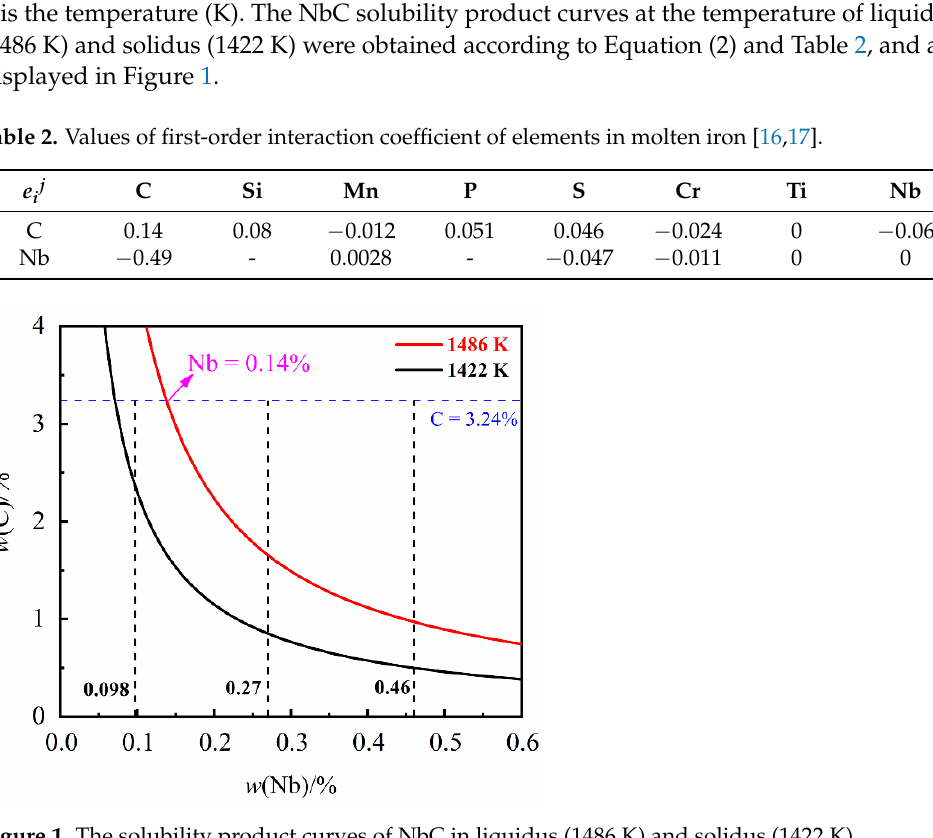
Table 1. The chemical composition of the samples after smelting (% by mass).